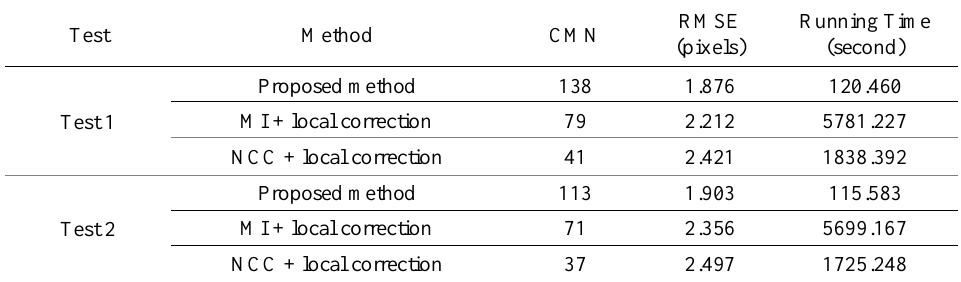
Table 2. Registration results of the proposed method, MI, and